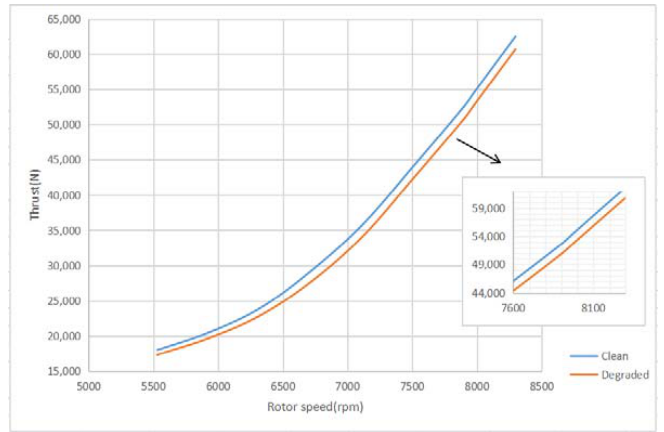
Figure 19. Comparison of the rotor speed to thrust relationship between a clean engine and de- graded engine.